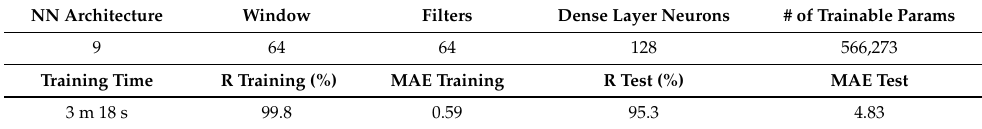
Table 4. Final digital twin architecture and performance